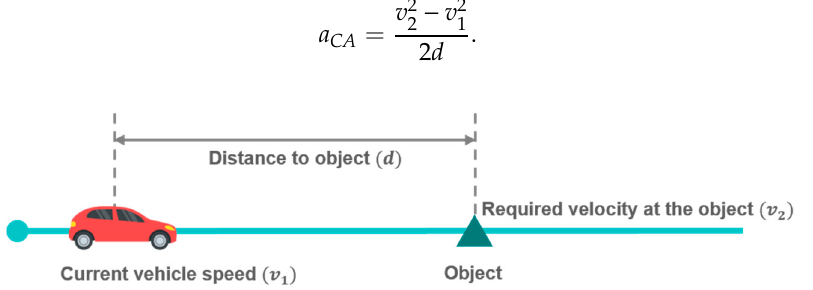
Figure 3. Driving situation for constant acceleration model.